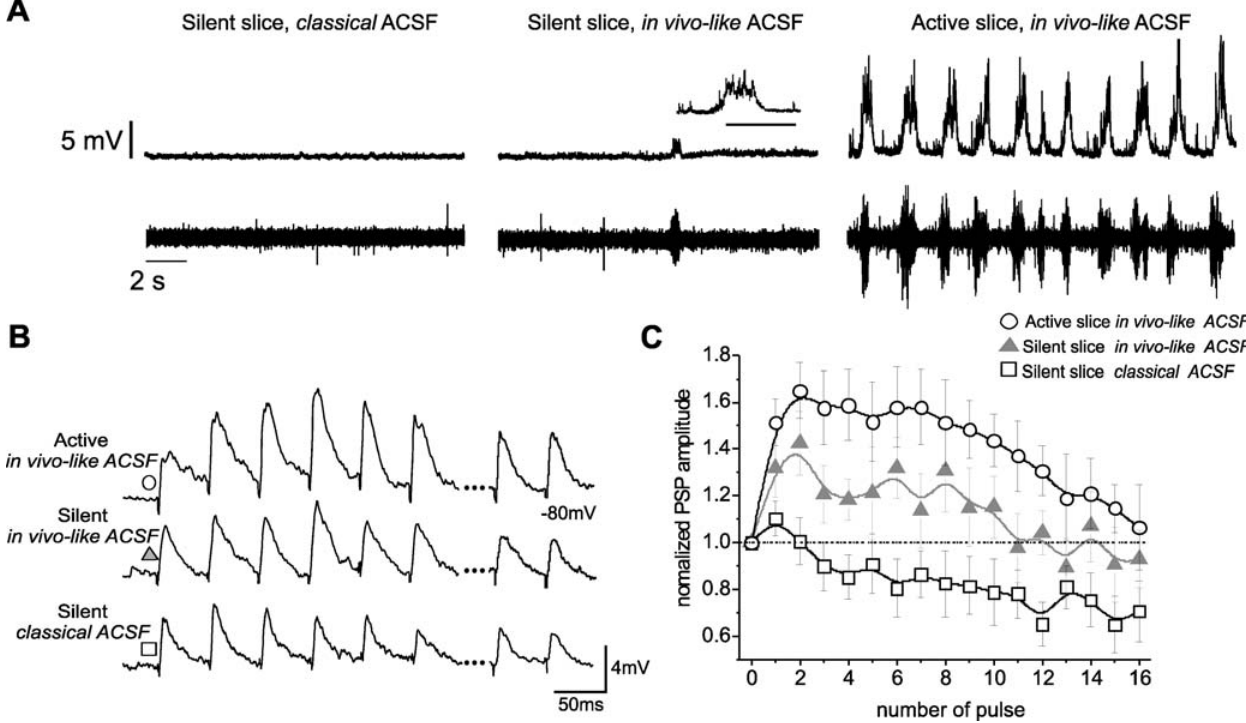
Figure 1. Short term synaptic plasticity of intracortical PSPs in active versussilent slices. A. Intra (top) and extracellular (bottom) recordings illustrating cellular and network activity repectively in the three conditions depicted in B and C. The recordings correspond to the same neuron and location in the slice. On the left, the slice is silent and it is immersed in the so-called classical ACSF (for composition of ACSF see Methods). In the middle traces the slices are in in vivo-like ACSF but spontaneous rhythmic activity has not developed yet, although occasional bursts of activity can be observed. The traces on the right show organized up and down states observable in both the recordings, in the case of the intracellular (top) the neuron being kept subthreshold. B. Raw traces of 16 PSPs recorded from a layer 2/3 neuron in the visual cortex induced by repetitive electrical stimulation (20 Hz) of layer 4. The first 6 and the last 2 PSPs of the 16 are shown. The same neuron was recorded while in three different funcional states of the cortical network: 1) top trace, PSPs recorded from an active, oscillatory slice, 2) middle trace, PSPs recorded from silent slices in ‘in vivo- like’ ACSF, and 3) bottom trace, PSPs recorded from silent slices in ‘classical’ ACSF. C. Averaged and normalized PSPs amplitudes for the same three experimental conditions described in A: active, oscillatory slice in ‘in vivo-like’ ACSF ( # ), silent slice in ‘in vivo-like’ ACSF ( m ) and silent slice in ‘classical’ ACSF ( % ). Each point corresponds to the average of several cells (between n=5 and 17) and the error bar represents 6 s.e.m. The plotted values correspond to the normalized ones with respect to the amplitude of the first PSP (at 0 sec). The connecting curve between points is a B-spline. All the recordings included in this graph were from slices that have been kept at least 20 min in the aforementioned solutions.